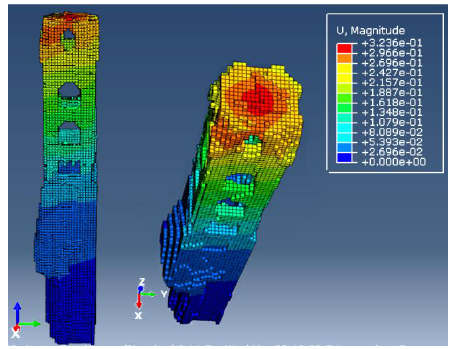
Figure 12. Static analysis